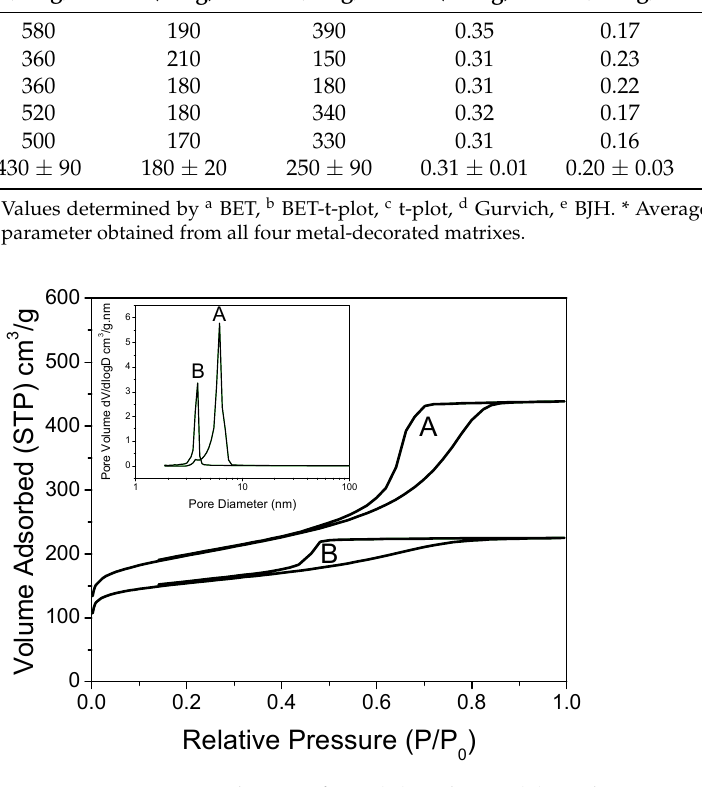
Figure 1. Nitrogen isotherms of GN (A) and G2N (B), with corresponding pore-size distribution obtained by BJH (inset). Table 1. Textural parameters of matrixes GN and G2N with and without decoration by metallic nanoparticles before their impregnation by LiBH 4 .